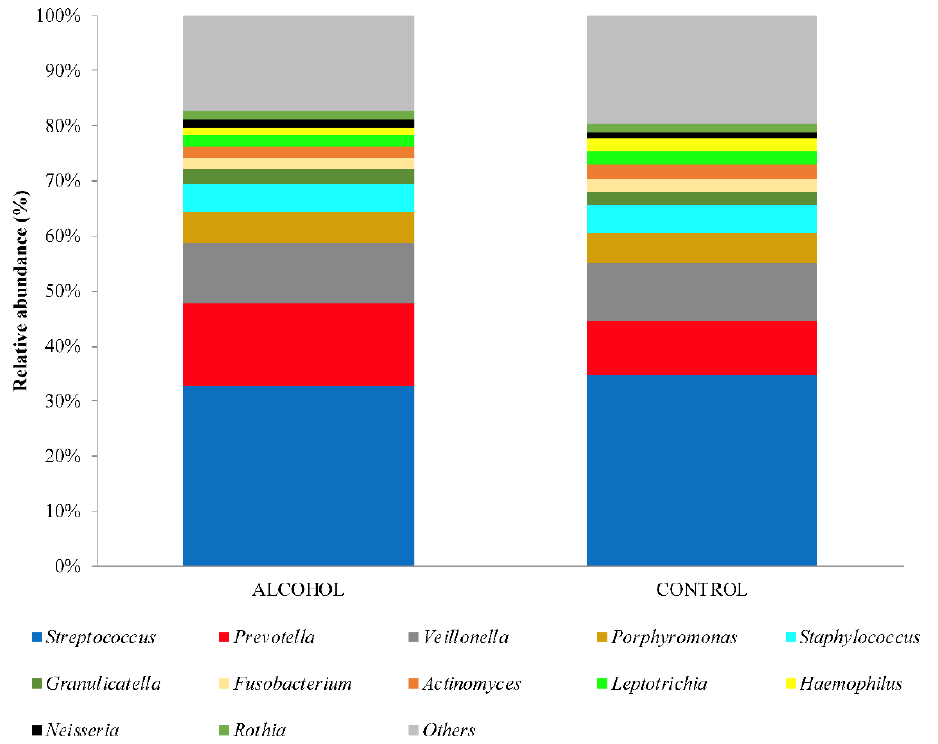
Figure 3. Stacked bar chart showing the taxonomic composition and relative abundance of the 13 major genera observed between the alcohol group and the control group. Taxa with very low read counts was collapsed into others category.